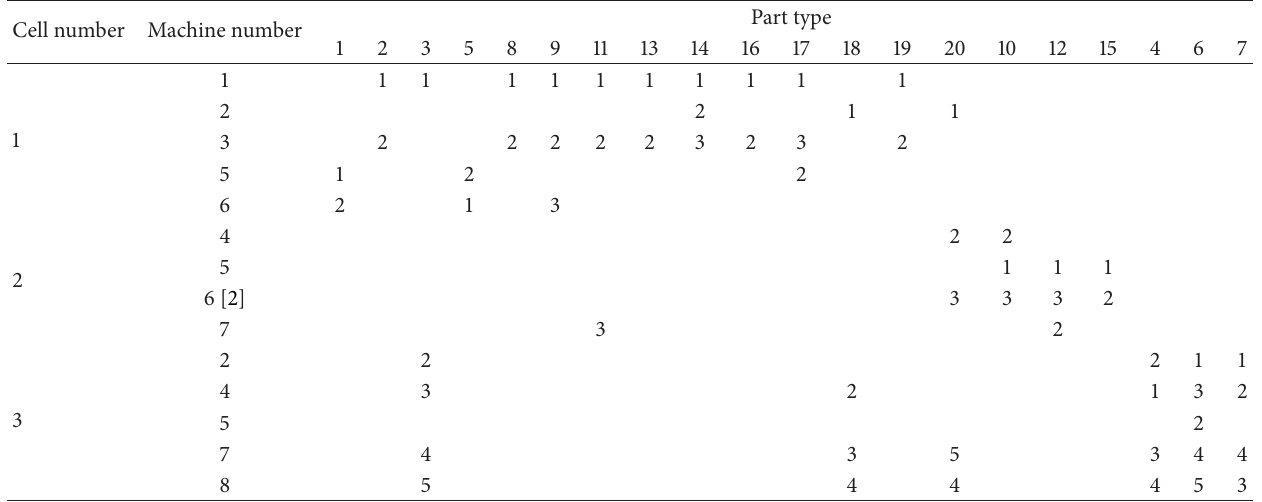
Table 9: A solution matrix for Example